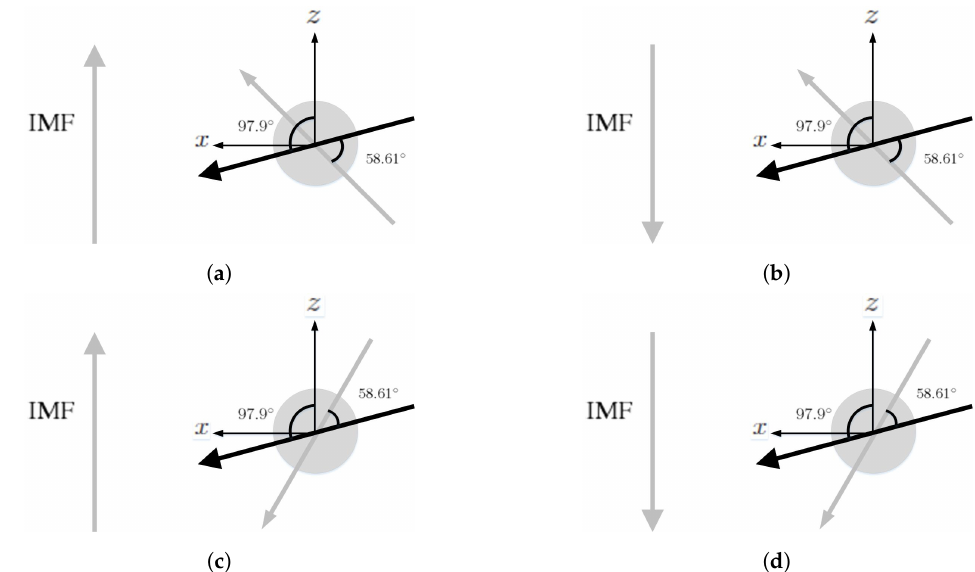
Figure 15. Scenarios of solar-wind blowing on Uranus. ( a ) initial dipole tilts up and towards the sun, northward IMF, ( b ) initial dipole tilts up and towards the sun, southward IMF, ( c ) initial dipole tilts down and towards the sun, northward IMF, ( d ) initial dipole tilts down and towards the sun, southward IMF. The rotational axis (black arrow) is tilted by 97.9 ◦ from the orbital normal and the dipole axis (grey arrow) is tilted by 58.61 ◦ from the rotational